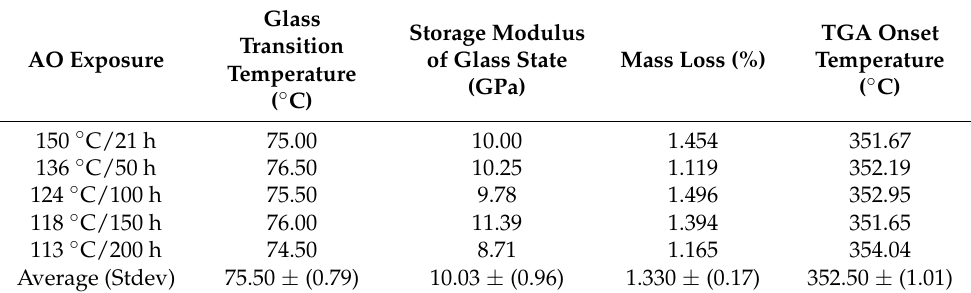
Thermomechanical properties and mass loss for five validation data sets in an AO